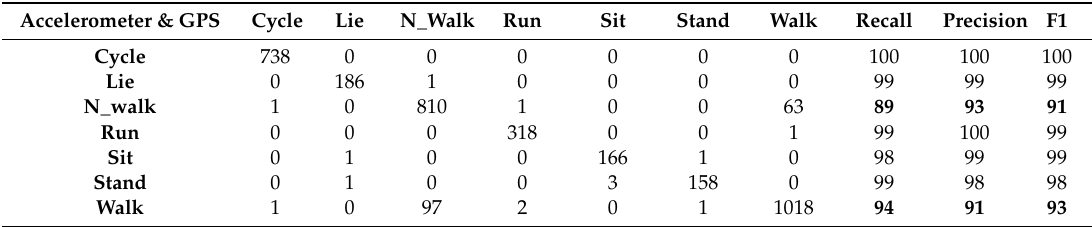
Table 7. Confusion matrix of a participant (with the highest GPS contribution) when using accelerometer and GPS data (Scenario 2).